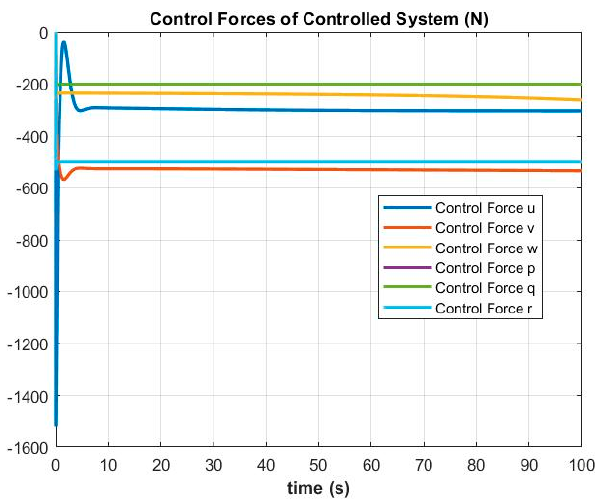
( ) u Q for the controlled system. Figure 13. The additional control forces ( Q u ) for the controlled